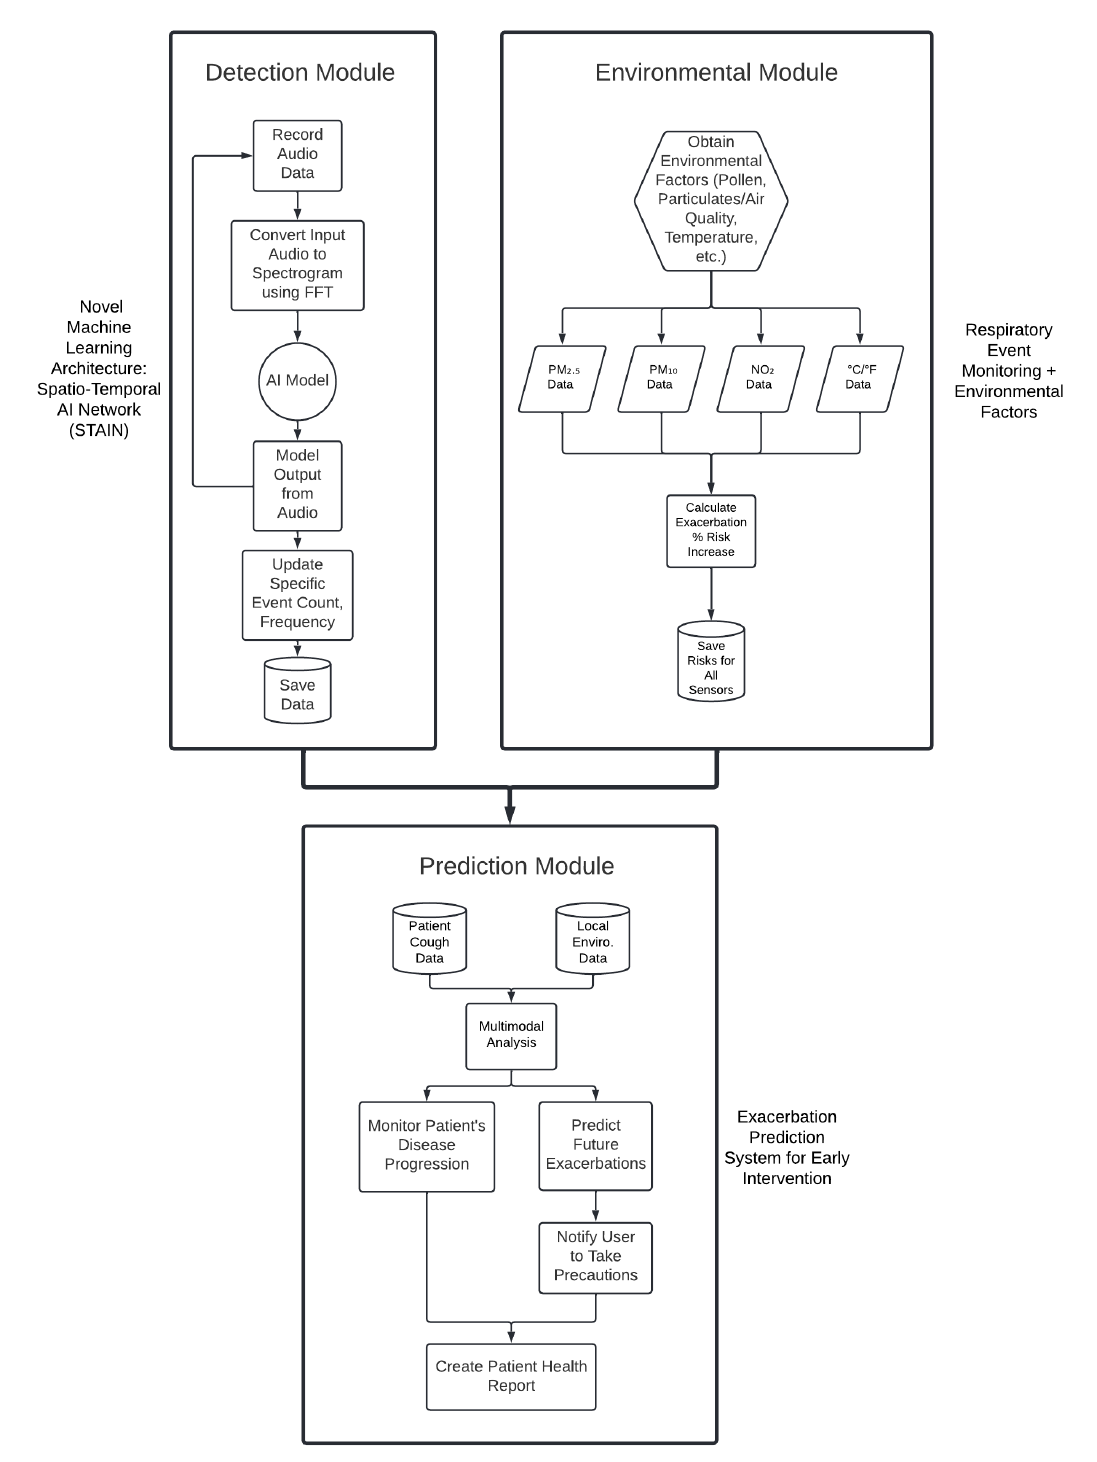
Figure 1. This flowchart represents the proposed system architecture for real-time multi-modal exacerbation prediction. The detection module depicts the respiratory event analysis system using a novel spatio-temporal artificial intelligence neural network. The environmental module depicts the disease exacerbation risk analysis system using local environmental factors. The prediction module takes the respiratory event data and trends from the detection module and exacerbation risk increase from the environmental module to predict future exacerbations and provide necessary alerts for early